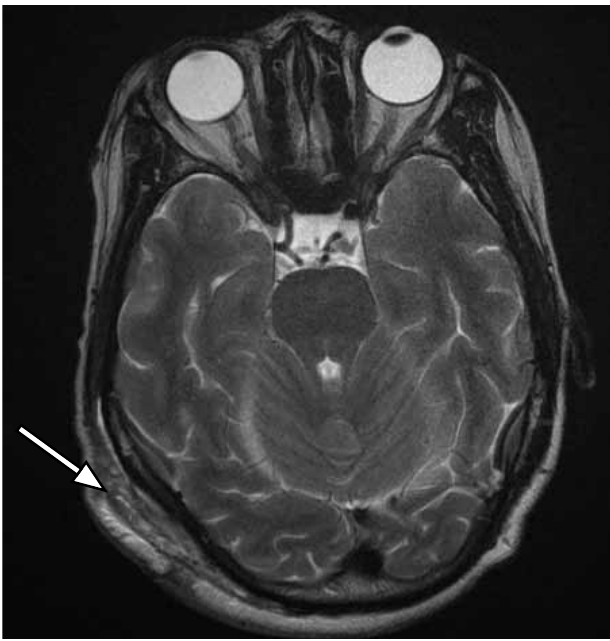
Fig. 1. Axial T2-weighted image of the brain demonstrating the right occipital plexiform neurofibroma (white arrow).